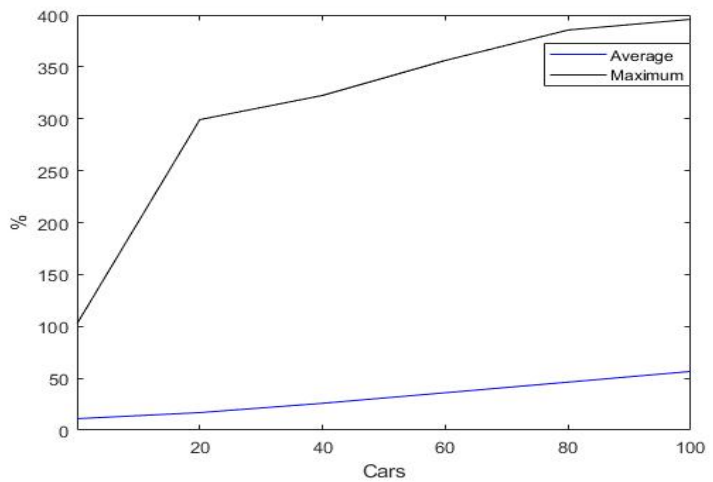
Figure 6. Maximum line loading (percentage) observed in the network versus average observed across all cables when plotted against EV penetration.